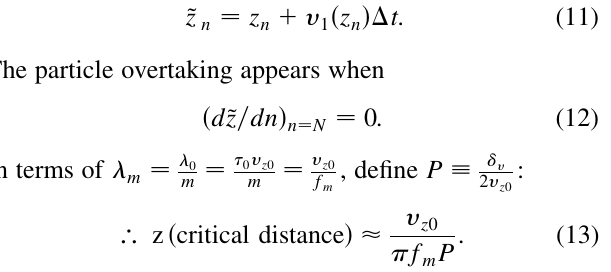
ð t (cid:6) t Þ plot zn a